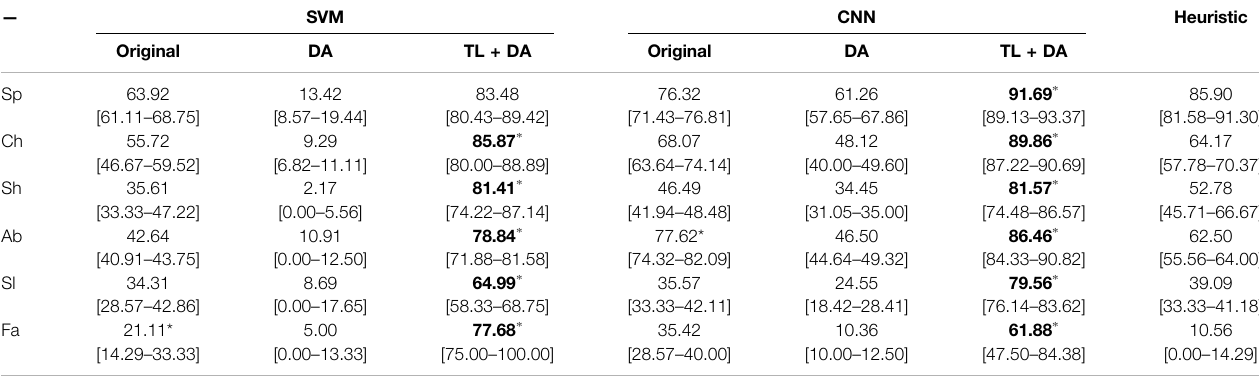
TABLE 4| Performanceofthemachinelearningmodelsforeach ofthesub-groupsoftheBSdataset.Theresultsarepresented asmediansensitivity(25thpercentile — 75th percentile) (%). On the left side, the results for the SVM. On the middle, the results for the CNN. On the right side, the results using the heuristic method in Charlton et al. (2021). The best results of each model that performed better than the heuristic approach for each breathing type are in bold.